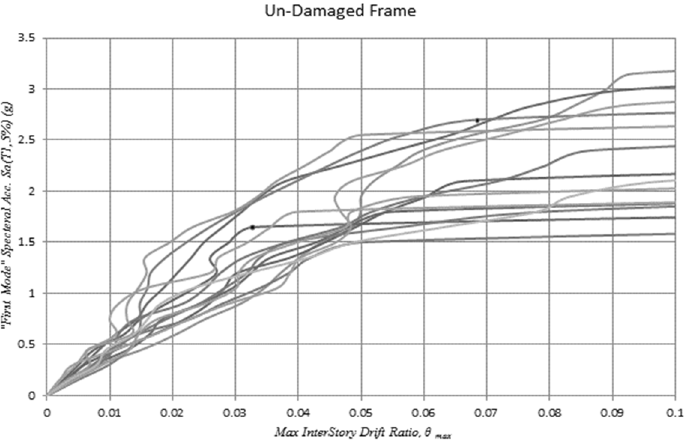
Figure 28. IDA curves obtained for a sound 20-story structural frame.